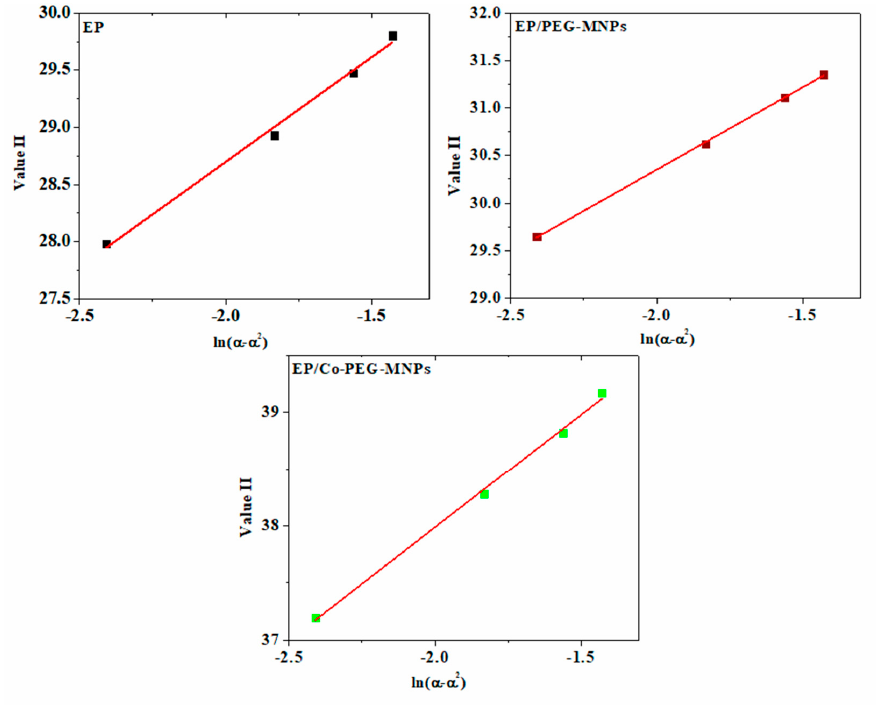
Figure A5. Variation of Value II of the samples prepared in this work at typical heating rate of 5 °C·min − 1 .